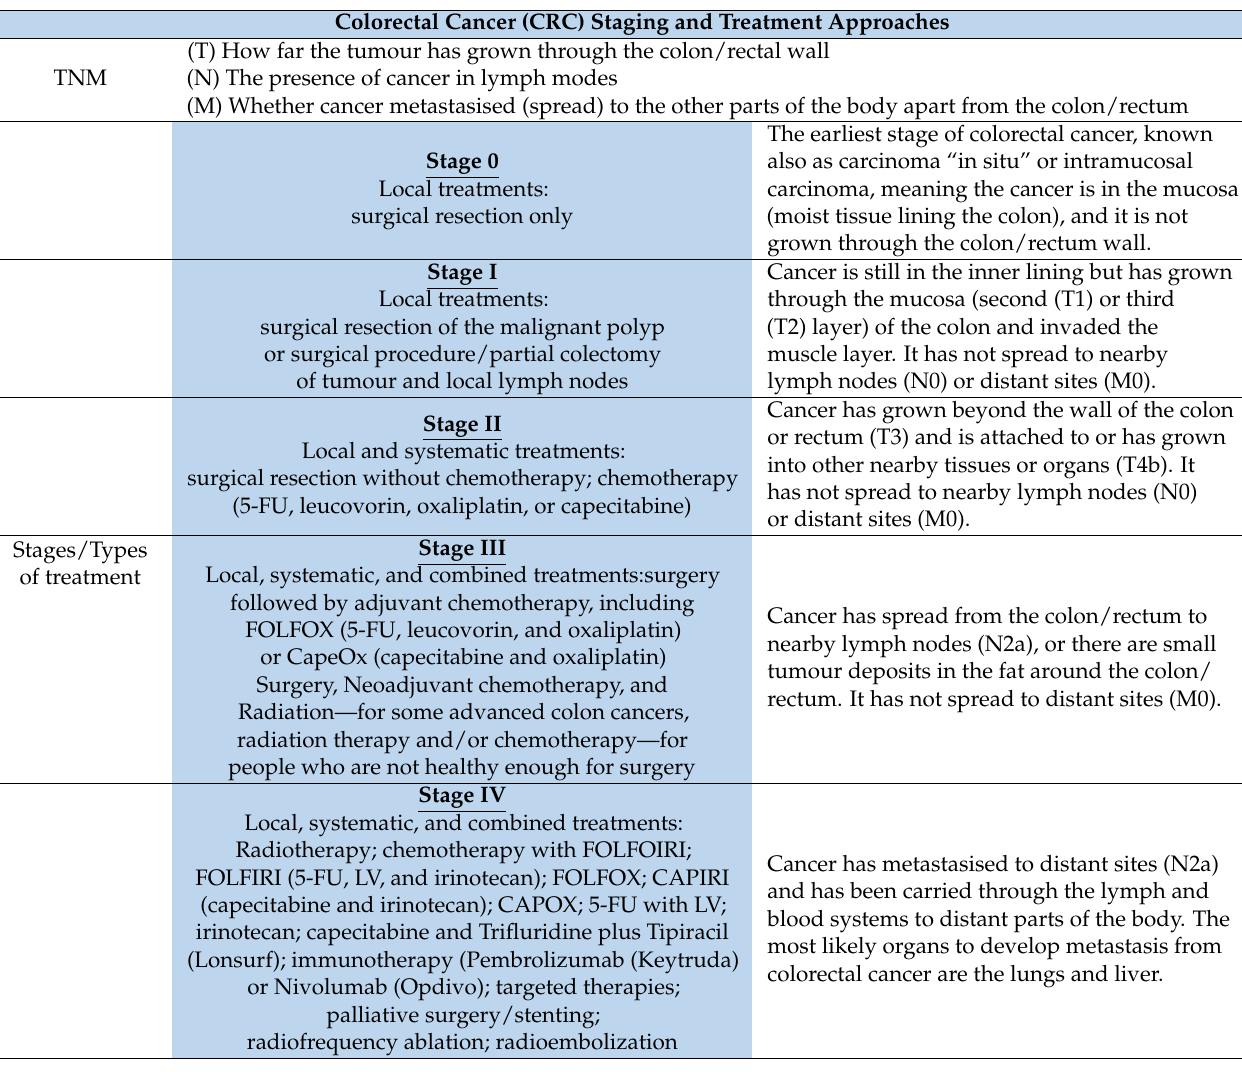
Table 1. Staging for colorectal cancer and types of corresponding therapeutic